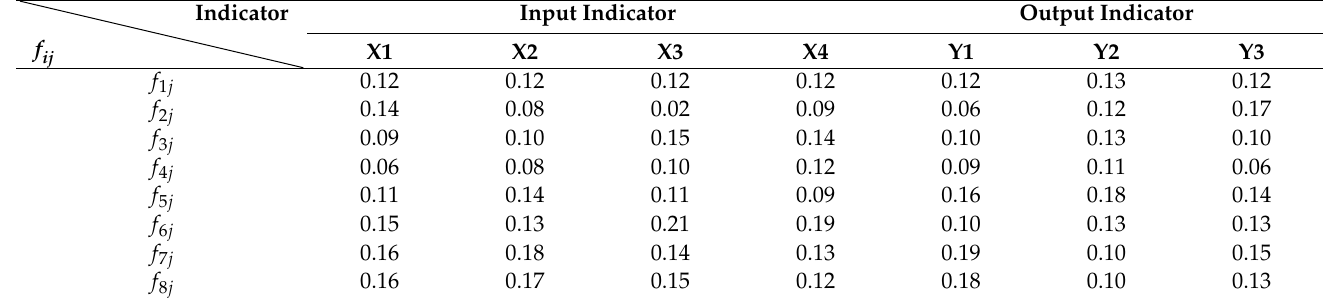
Table 5. The weight value of green building input and output indicators.